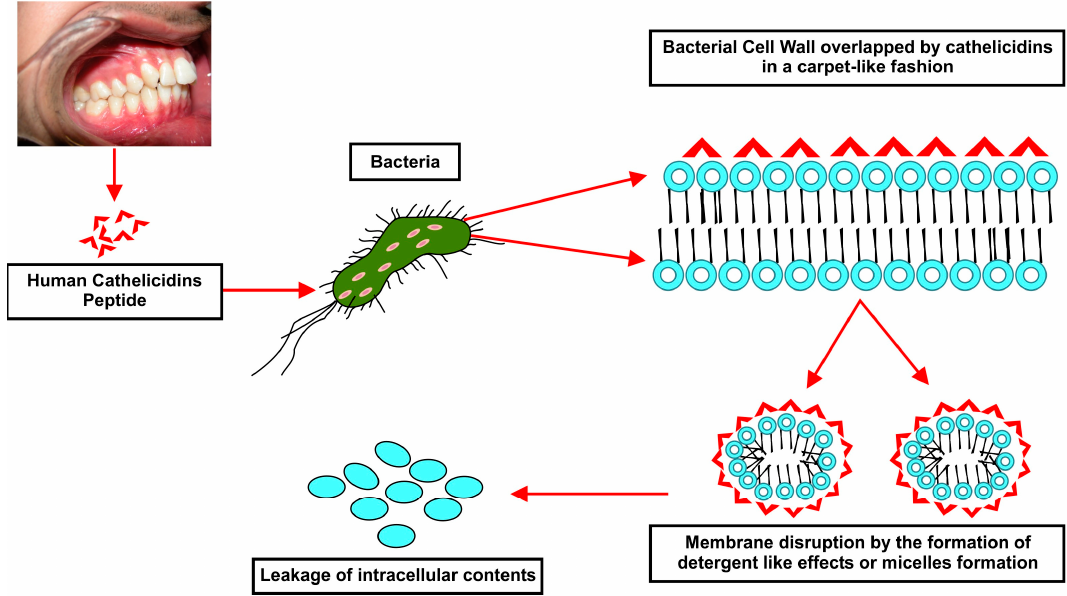
Figure 2. Illustration representing the cathelicidins mechanism of action against microbes specifically for LL-37 and oral cavity.